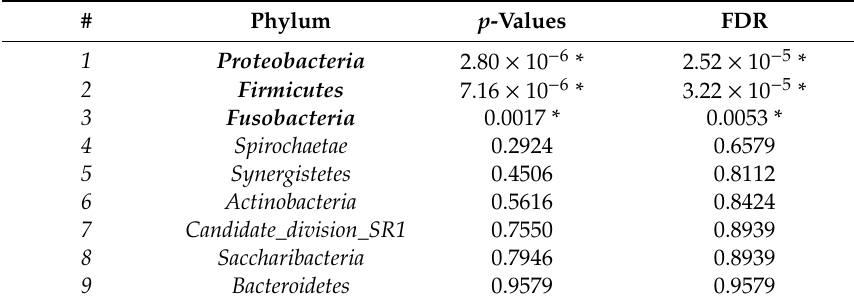
Table 3. The top features identified by univariate analysis at the phylum level for non-smokers versus smokers (regardless of gender).